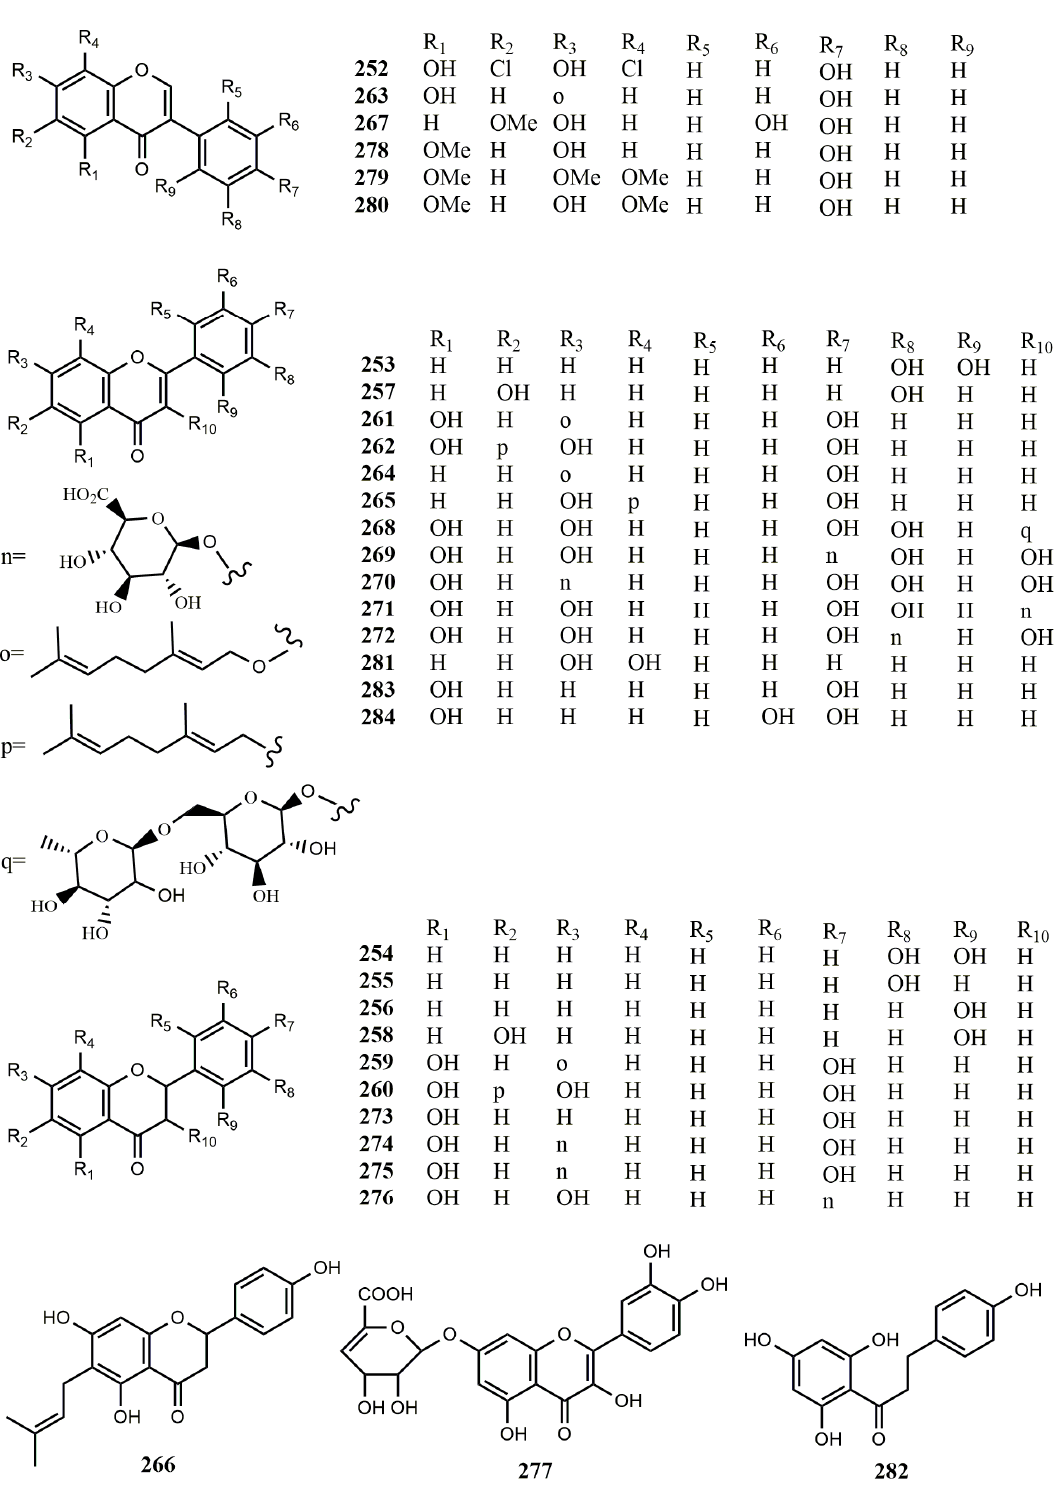
Figure 8. Biotransformation of isoflavones and flavonoids 252 – 284 by actinomycetes.